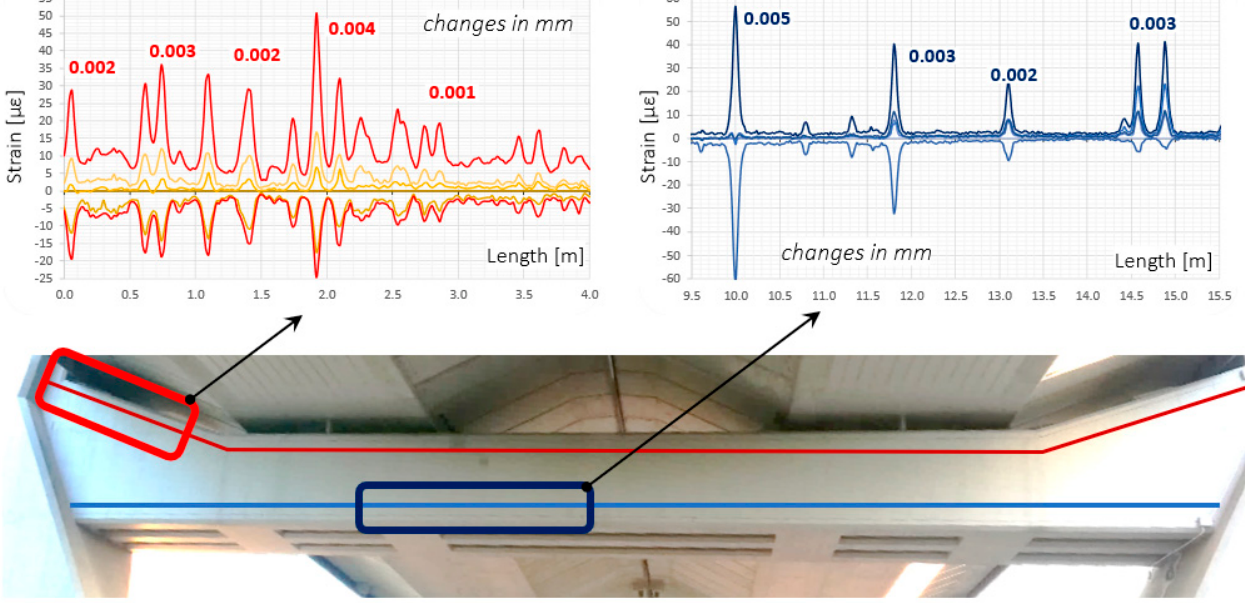
Figure 21. Example strain profiles over selected sections of the lower and upper monolithic sensor with crack width analysis.